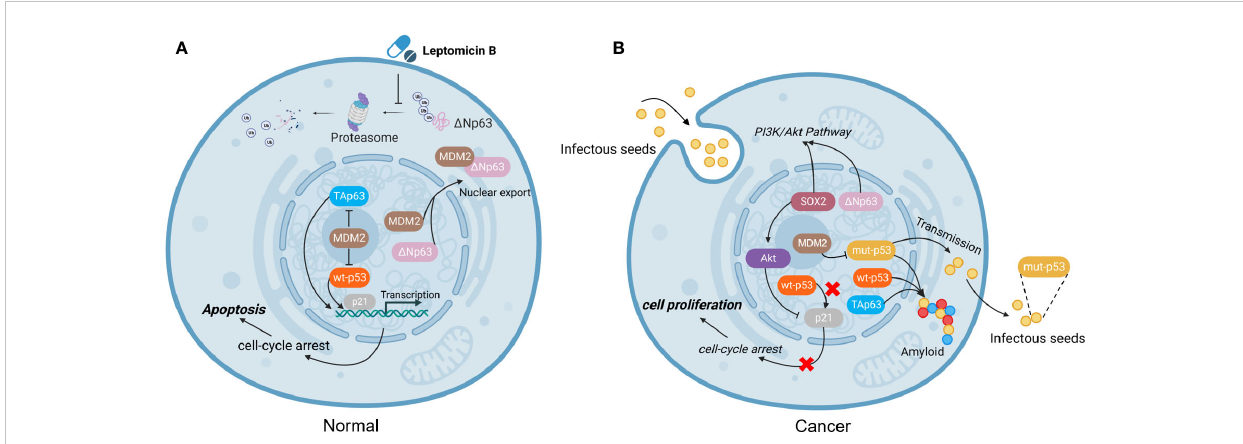
FIGURE 2 The function of mutated p53. (A) In normal cells, MDM2 plays an important role in regulating apoptosis. MDM2 binds to D Np63 and promotes its entry into the cytoplasm for degradation via proteasome, which can be blocked by the drug Leptomycin B (63). (B) In tumor cells, mut-p53 behaves in a prion-like behavior, not only possessing “ seeding ” ability and spreading to other cells, but also forming amyloid aggregates with TAp63 and wt-p53, leading to inactivation and promoting cell proliferation. However, MDM2 can block the aggregation of mut-p53, prevent mut-p53 from binding to TAp63, and alleviate mut-p53-related suppression to TAp63 (13, 64). (Created with